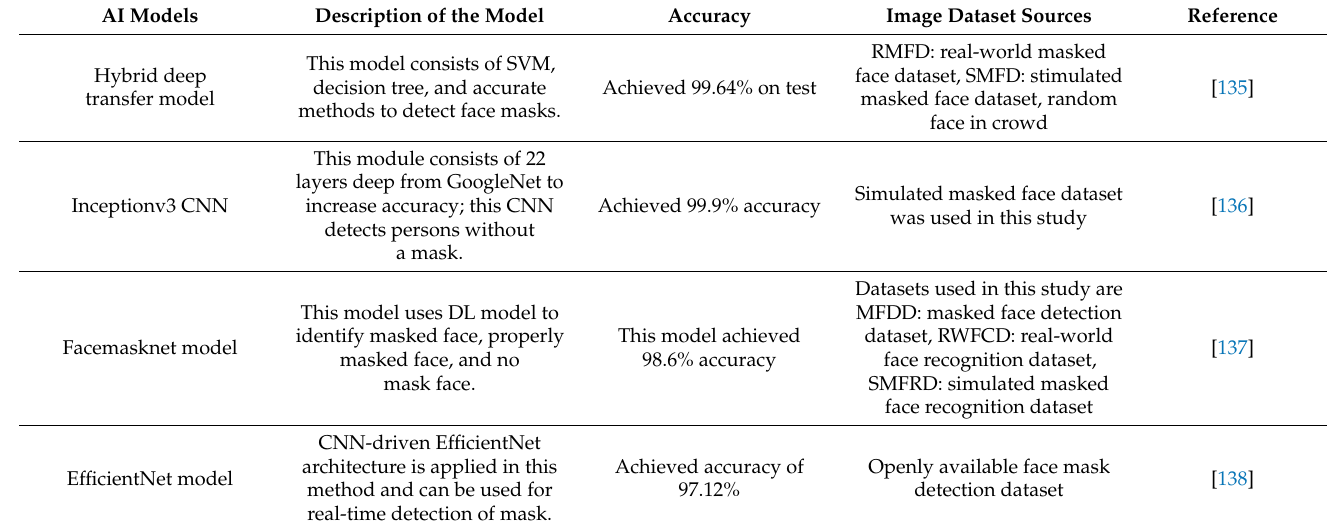
Table 2. Artificial Intelligence-based models for detecting face